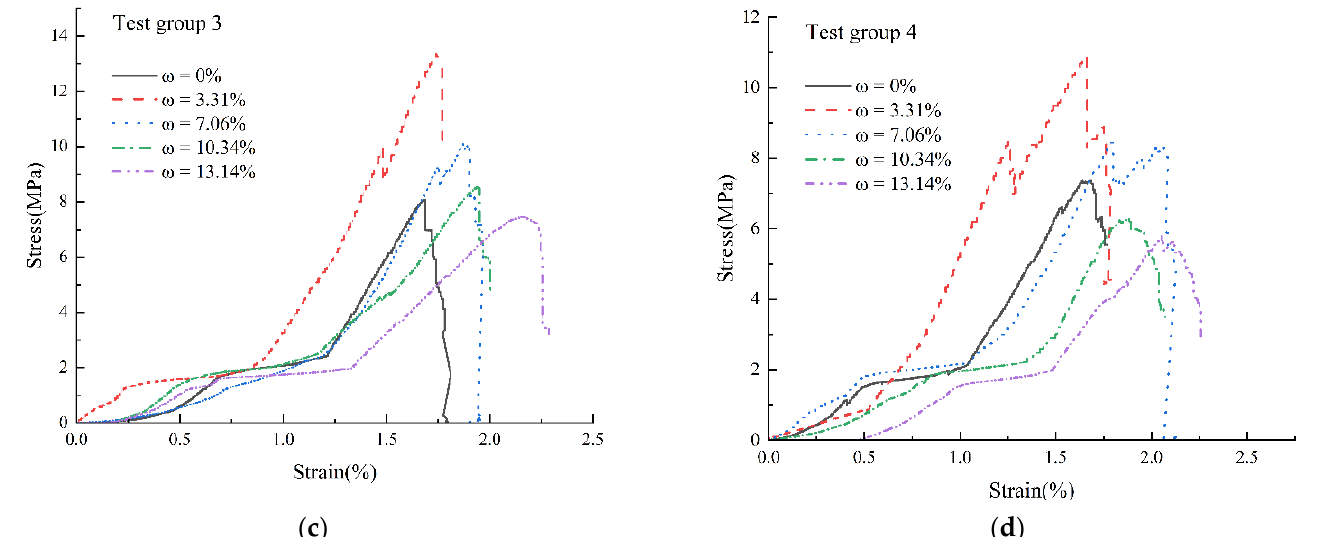
Figure 5. Uniaxial compressive stress–strain curves of coal samples of different moisture content. ( a ) Loading rate: 0.05 mm/min; ( b ) loading rate: 0.10 mm/min; ( c ) loading rate: 0.20 mm/min; ( d ) loading rate: 0.50 mm/min.